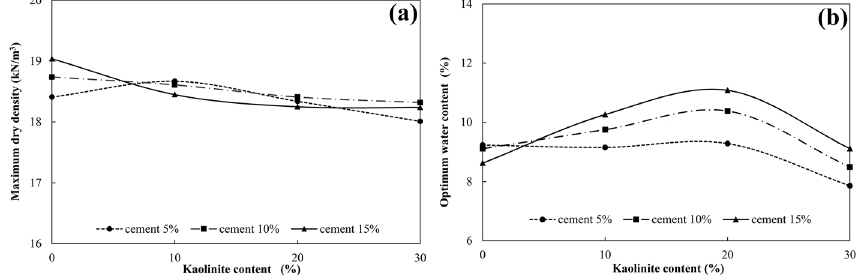
Fig. 6 The graph of maximum dry density and optimum water content for the CSG mixtures containing kaolinite